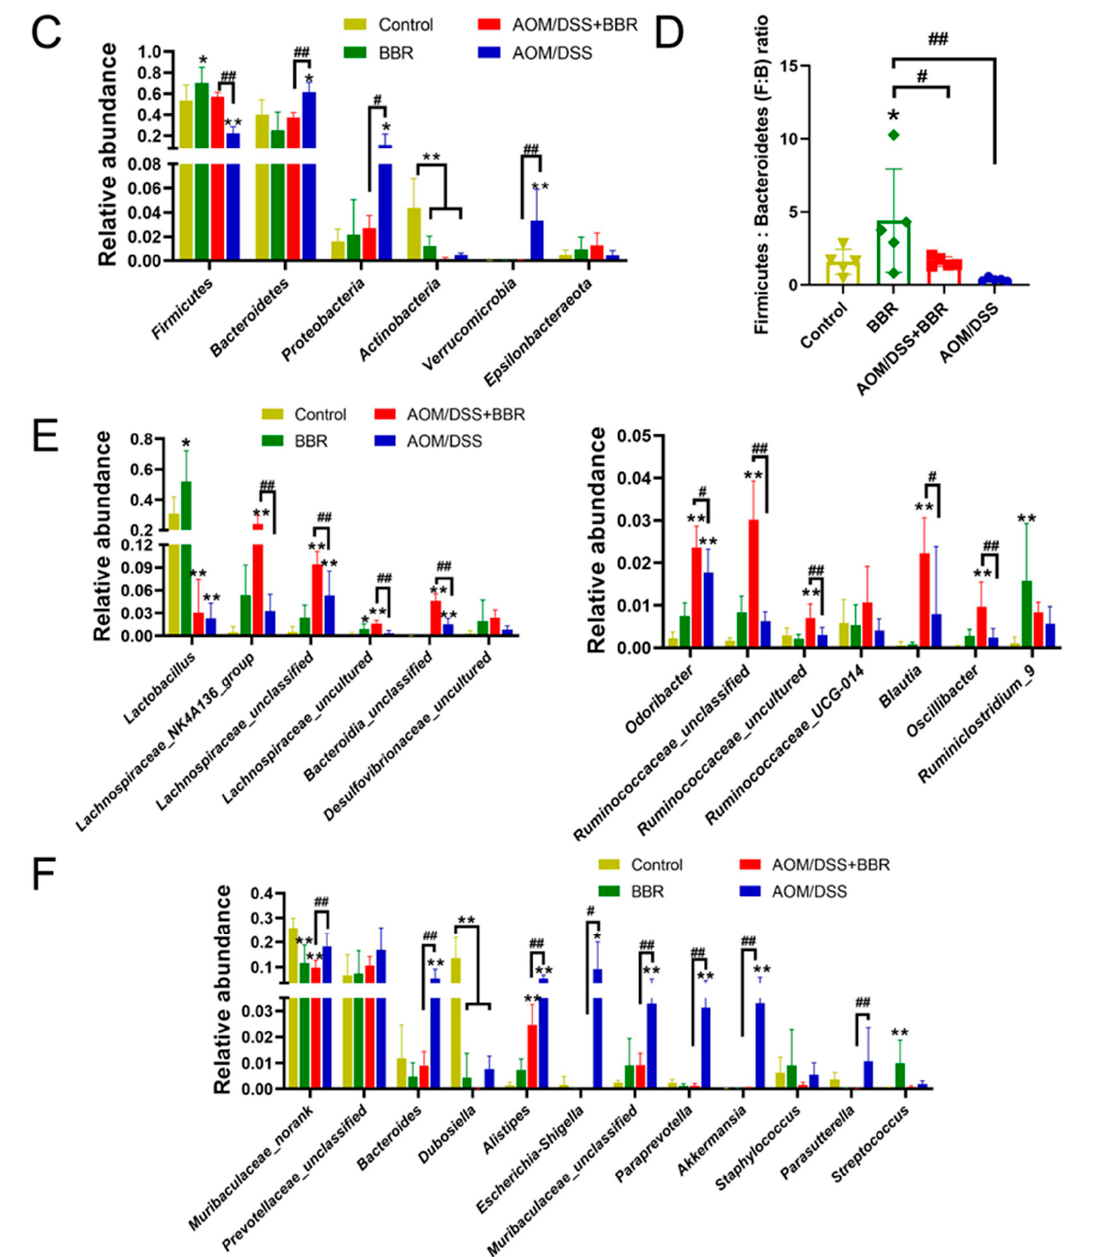
Figure 7. The effect of BBR on gut microbiota composition. The gut microbiota composition profiles at the phylum ( A ) and genus ( B ) level. Less abundant bacteria are grouped under the category “Other”, ( n = 5). ( C ) Relative abundance of gut microbiota at the phylum level ( n = 5). ( D ) The phylum Firmicutes: Bacteroidetes (F:B) ratio in each group. ( E ) Up-regulated gut microbiota in the AOM/DSS + BBR group but low in the AOM/DSS group ( n = 5). ( F ) Down-regulated gut microbiota in the AOM/DSS + BBR group but high in the AOM/DSS group ( n = 5). Data are presented as mean ± SEM of the indicated number of independent experiments. * p < 0.05, ** p < 0.01 vs. Control group, # p < 0.05, ## p < 0.01 vs. AOM/DSS